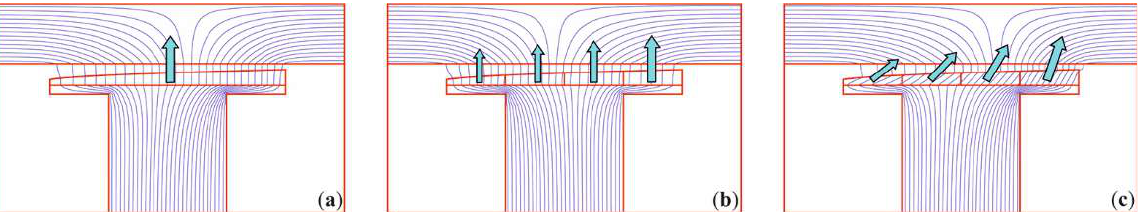
Figure 13. Magnetic pole of SM with a variable air gap and constant magnetization in the y -direction- initial configuration ( a ); PM divided into 4 parts with optimized magnetization in the y -direction ( b ); PM with optimized magnetization in both directions ( c ).